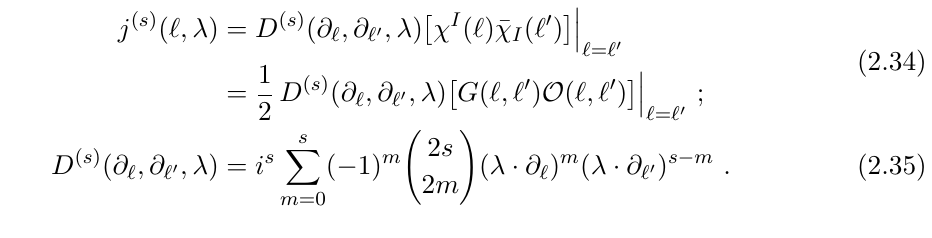
) in the shaded region, the other operators couple to it as a single 0 1 , ‘ 1 ) 0 2 , ‘ 4